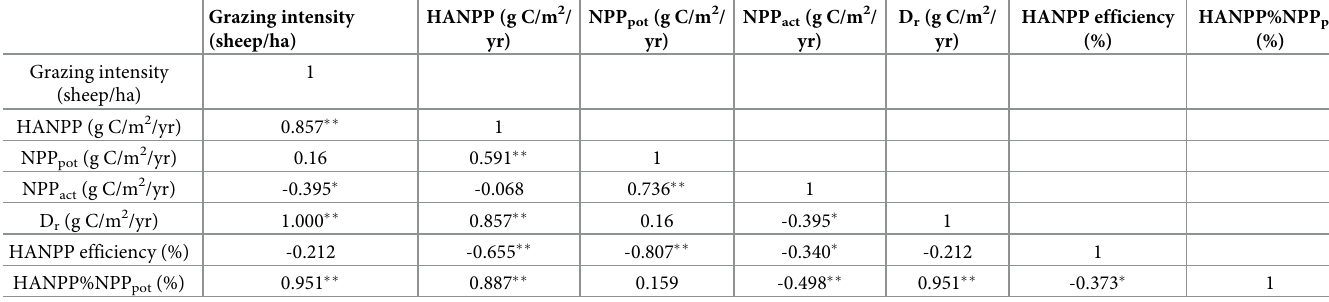
� significant correlation at P < 0.05 according to Pearson’s correlation analysis �� Extremely significant correlation at P < 0.01 according to Pearson’s correlation